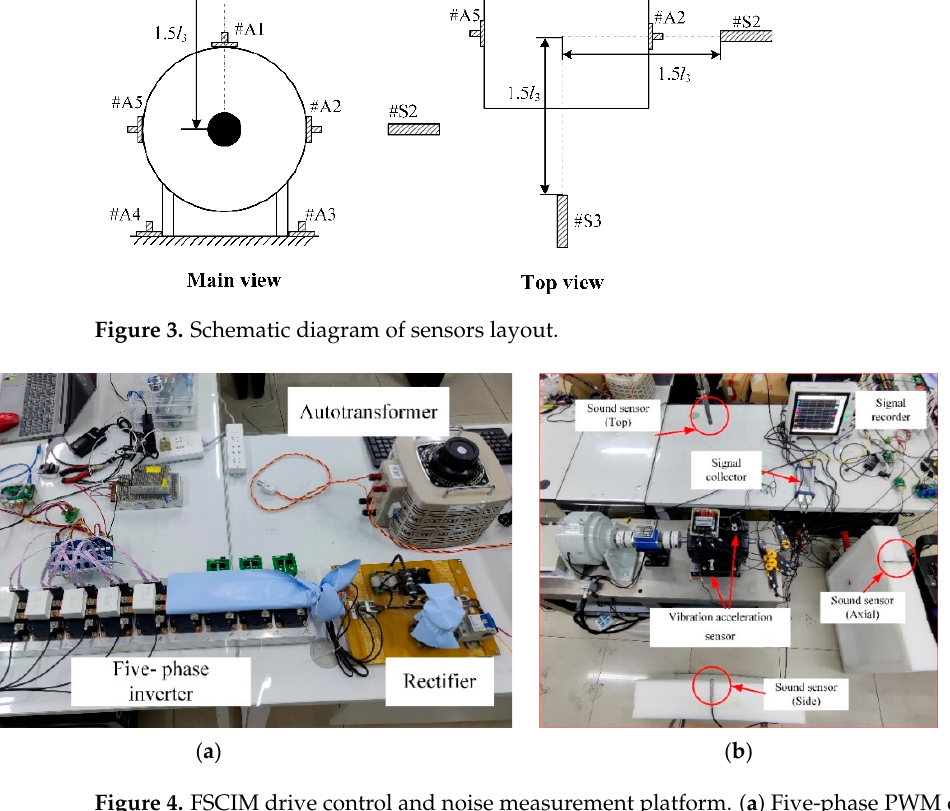
Figure 4. FSCIM drive control and noise measurement platform. ( a ) Five-phase PWM drive system; ( b ) vibration-noise measurement system.